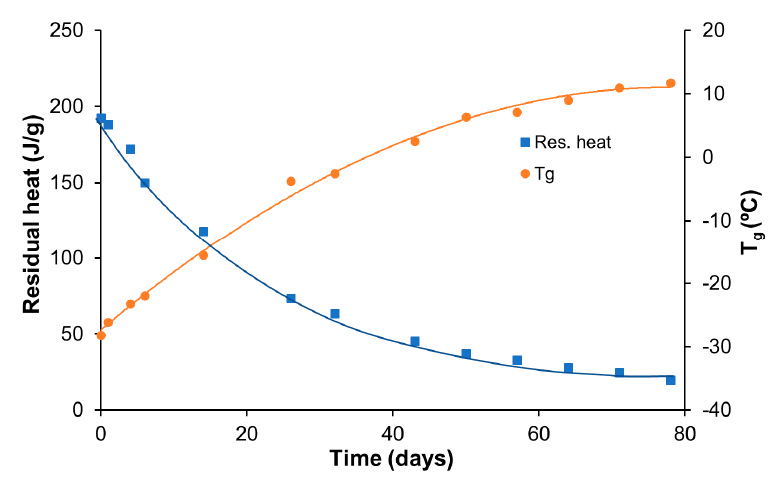
Figure 14. Prolonged storage stability monitoring of FEMA 3D 25.